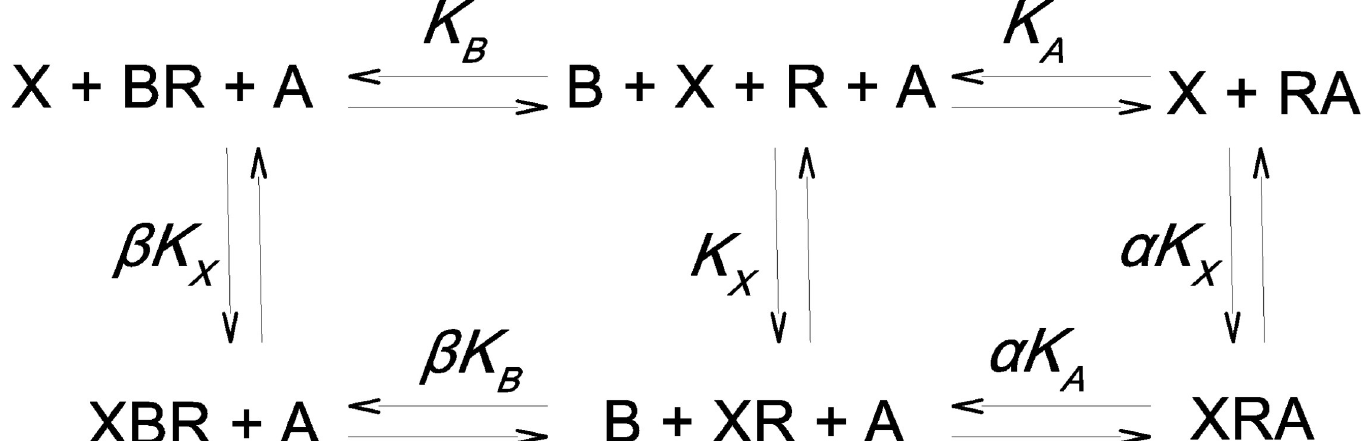
Fig 2. Two allosteric modulators binding to the same site. Allosteric interaction between tracer X and allosteric modulators A and B at receptor R, assuming that the two allosteric modulators compete for the same allosteric site. Beside parameters in Fig 1 , K B is the equilibrium dissociation constant of allosteric modulator B at the vacant receptor and β is the factor of binding cooperativity between tracer and allosteric modulator B.